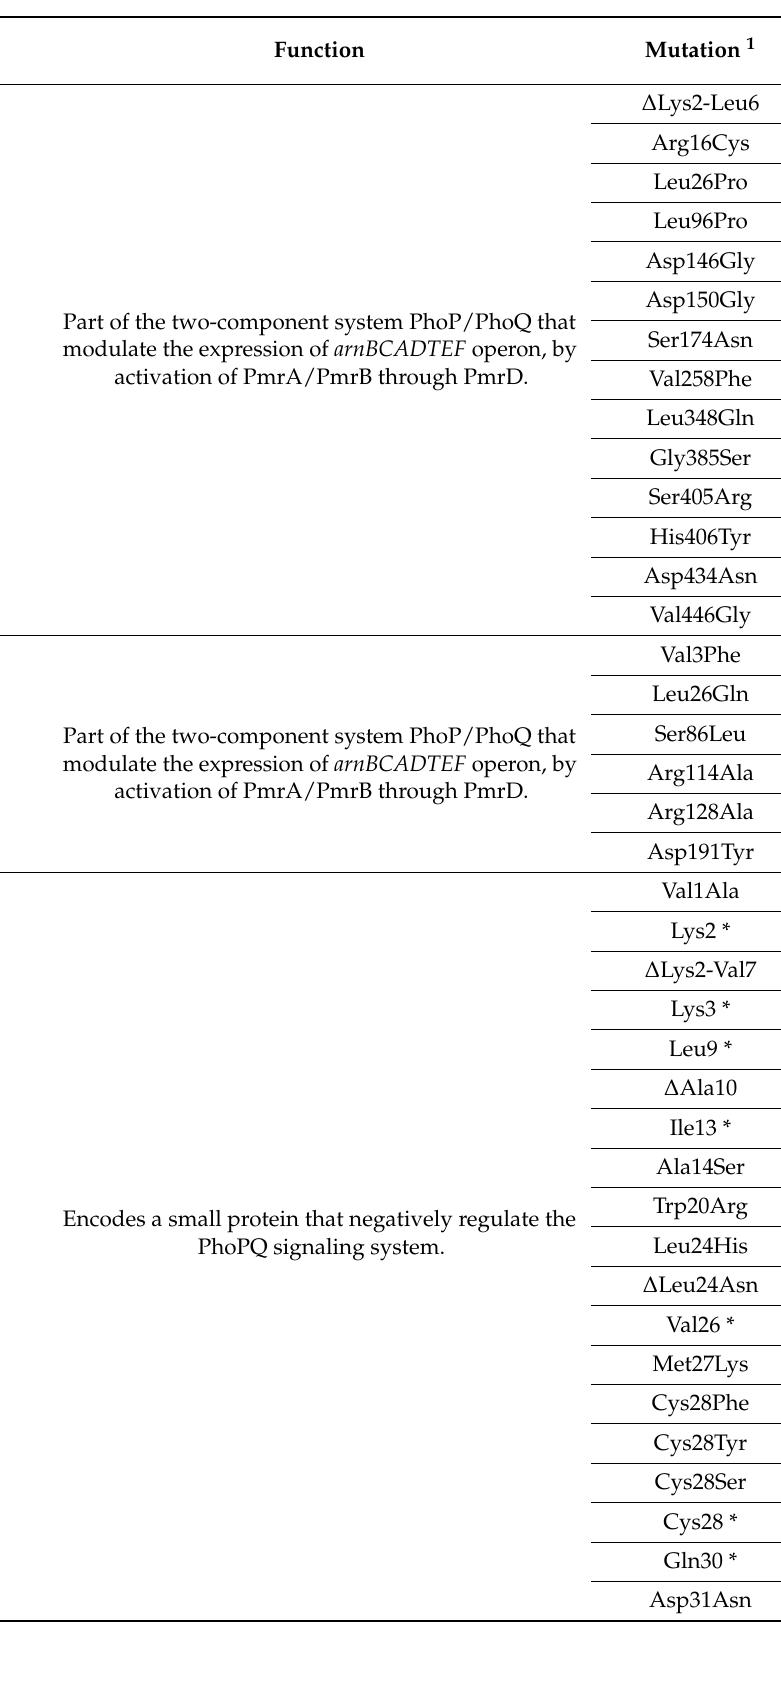
Table 1. Klebsiella pneumoniae genes involved in LPS modification, gene product function, and mutations reported in the